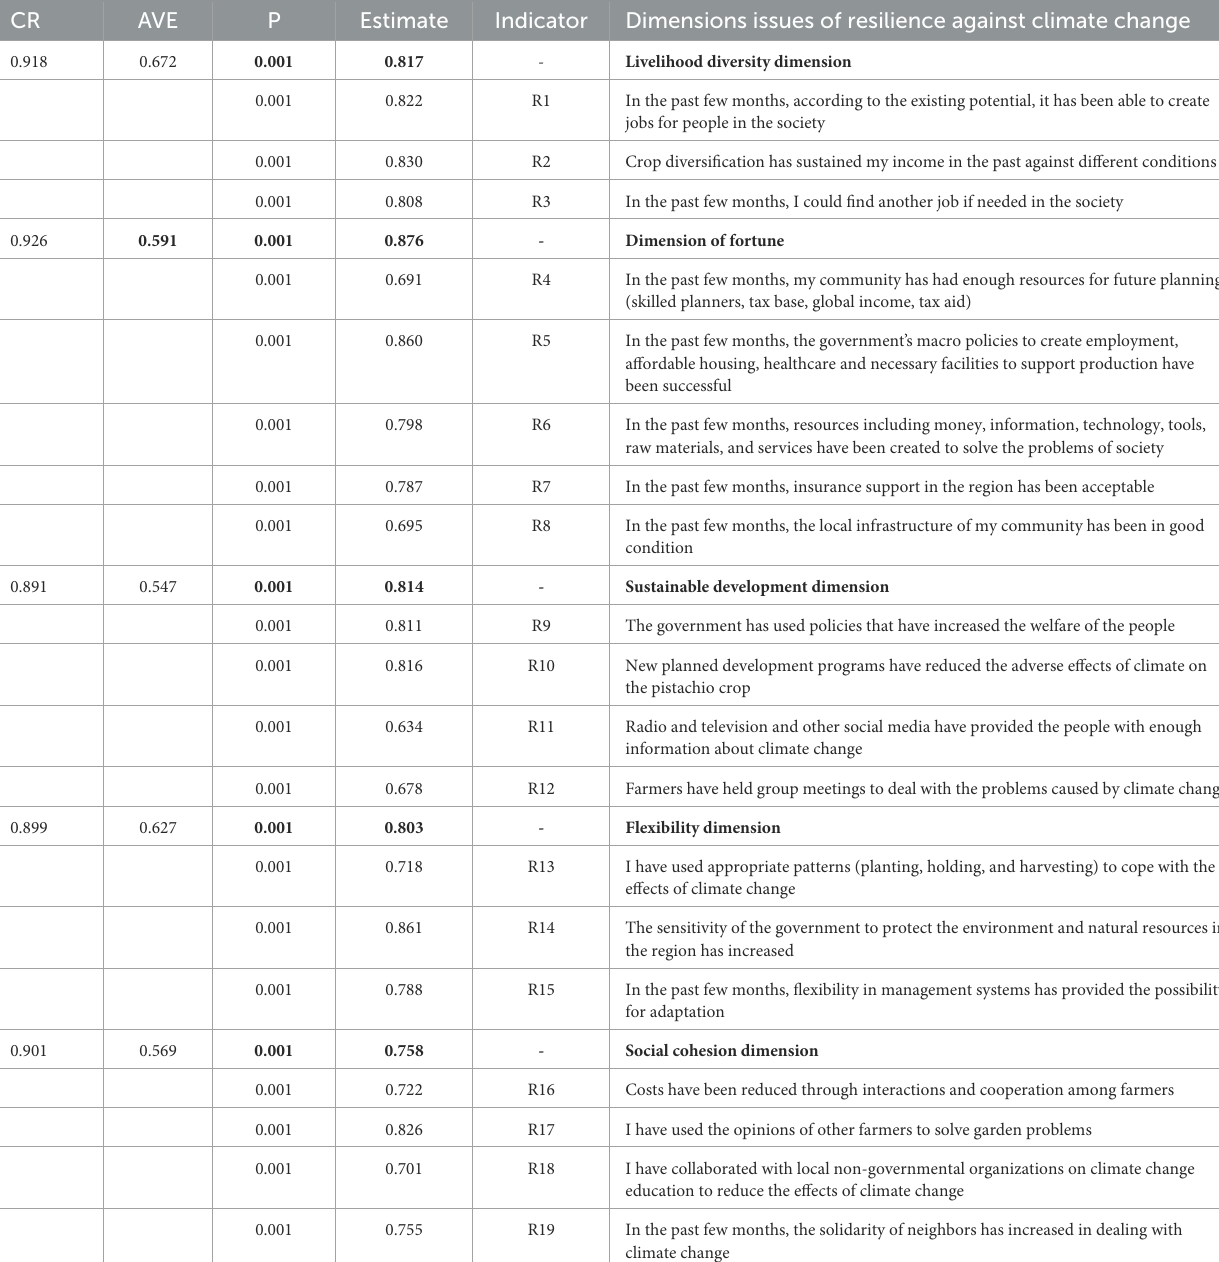
TABLE 6 Summary of the information of the variable measurement model of resilience against climate change. CR